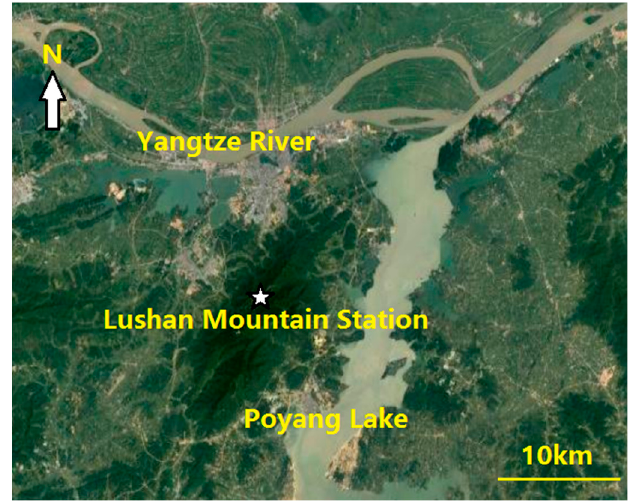
Figure 1. Map of the observation site.